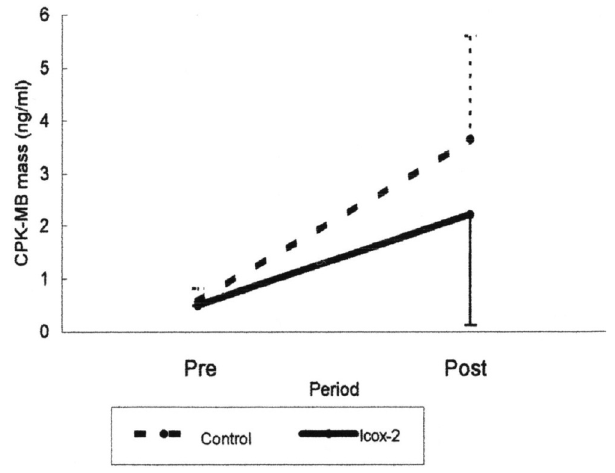
Figure 2 - Graph of the values of CPK-MB mass during the pre and post infarction periods in the control dogs and in the dogs treated with icox-2